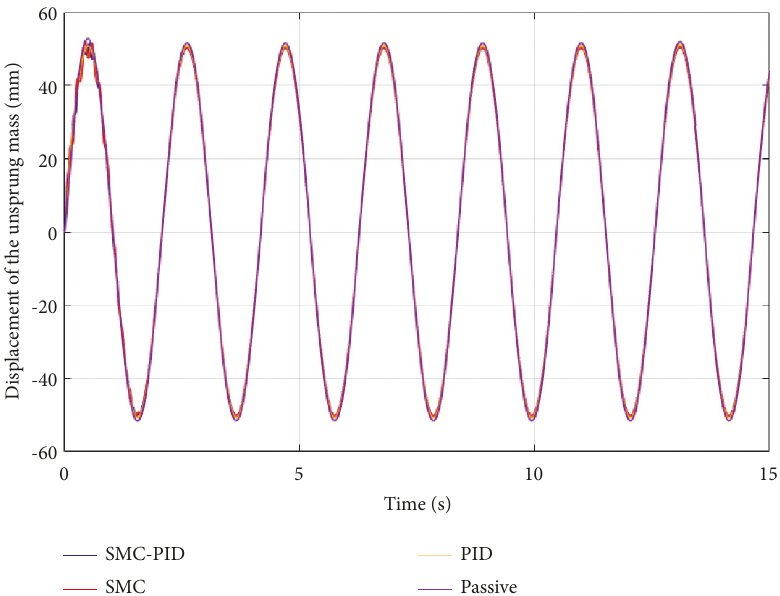
Figure 6: Displacement of the un-sprung mass (Case